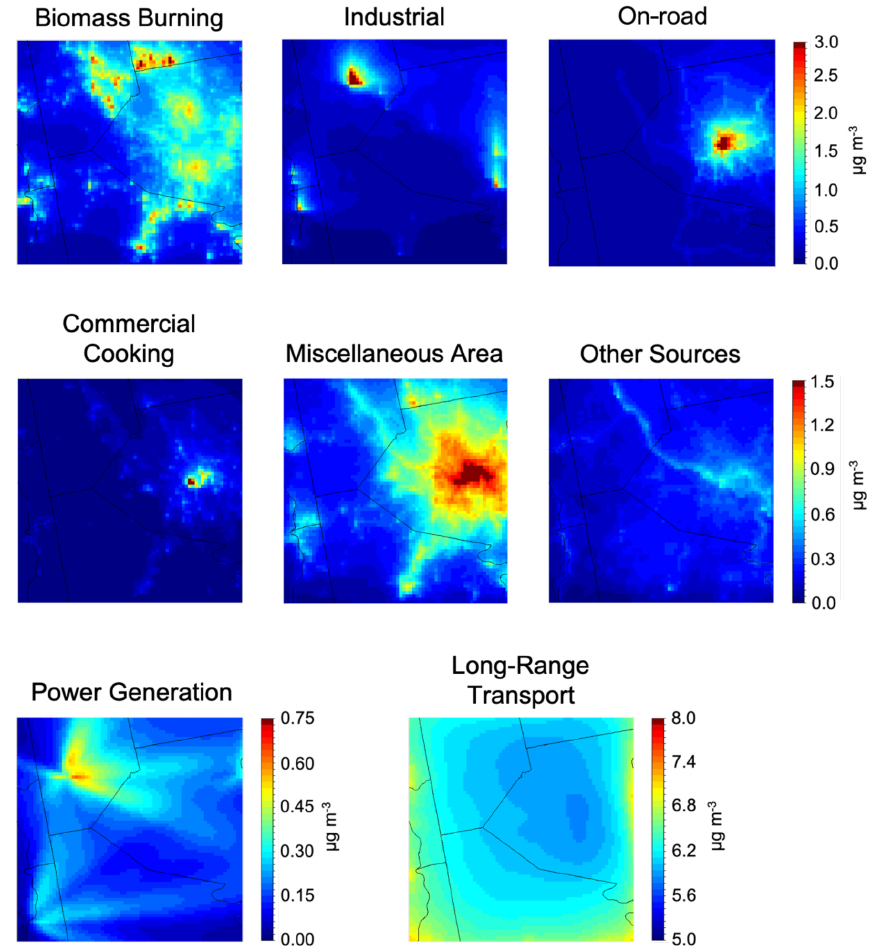
Figure 5. Contribution of each source to total PM 2 . 5 during February 2017. Different scales are used for the various